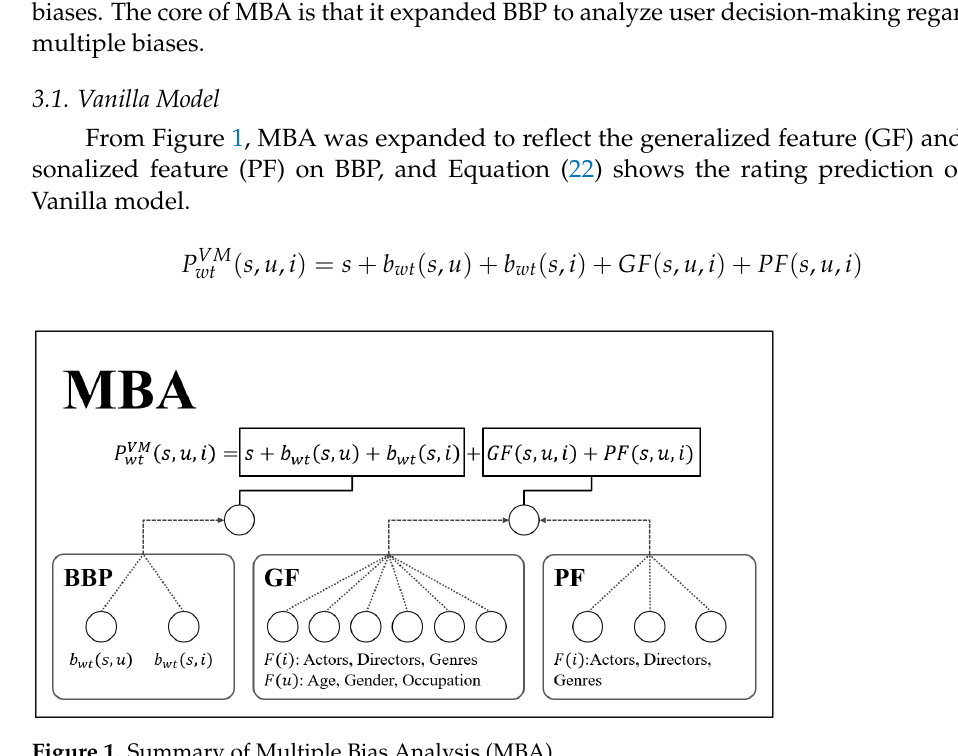
Figure 1. Summary of Multiple Bias Analysis